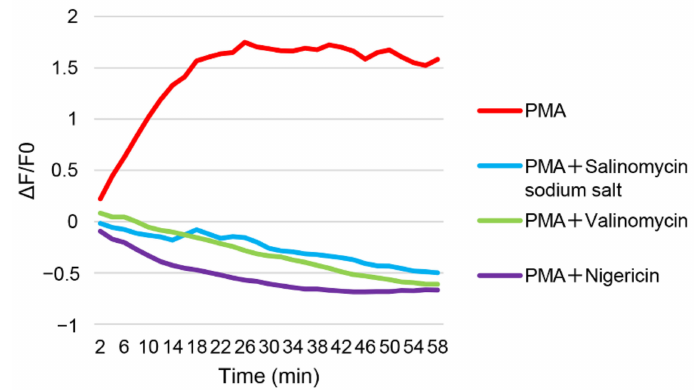
Figure 4. Ionophore antibiotics alter the Ca 2+ concentration dynamics in cultured cells. The Fcwf- 4 cells were transfected with pcDNA-LUCI-GEC01. The cells were incubated for 48 h, following treatment with PMA and salinomycin, valinomycin, or nigericin (12.5 µ M, 25 µ M, and 6.3 µ M, respectively) at maximal concentrations that did not cause cell toxicity, or 0.3% DMSO for 60 min. Image acquisition was performed using a laser scanning confocal microscope. Images were analyzed using the ImageJ-Fiji software. Fcwf-4, Felis catus whole fetus-4; PMA, phorbol 12-myristate